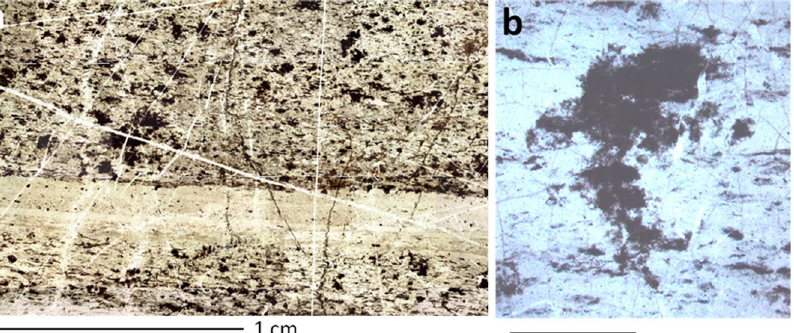
Figure 5. Hydrothermal chert facies from the 3.33 Ga-old Josefsdal Chert, Barberton Greenstone Belt, South Africa 6 ; ( a ) large-scale photomicrograph showing layered concentrations of disseminated carbonaceous clots interpreted as possible heterotrophic colonies; ( b ) details showing one of the clots with a “spiky” three dimensional morphology, having no relationship to the bedding plane layers, indicating in situ